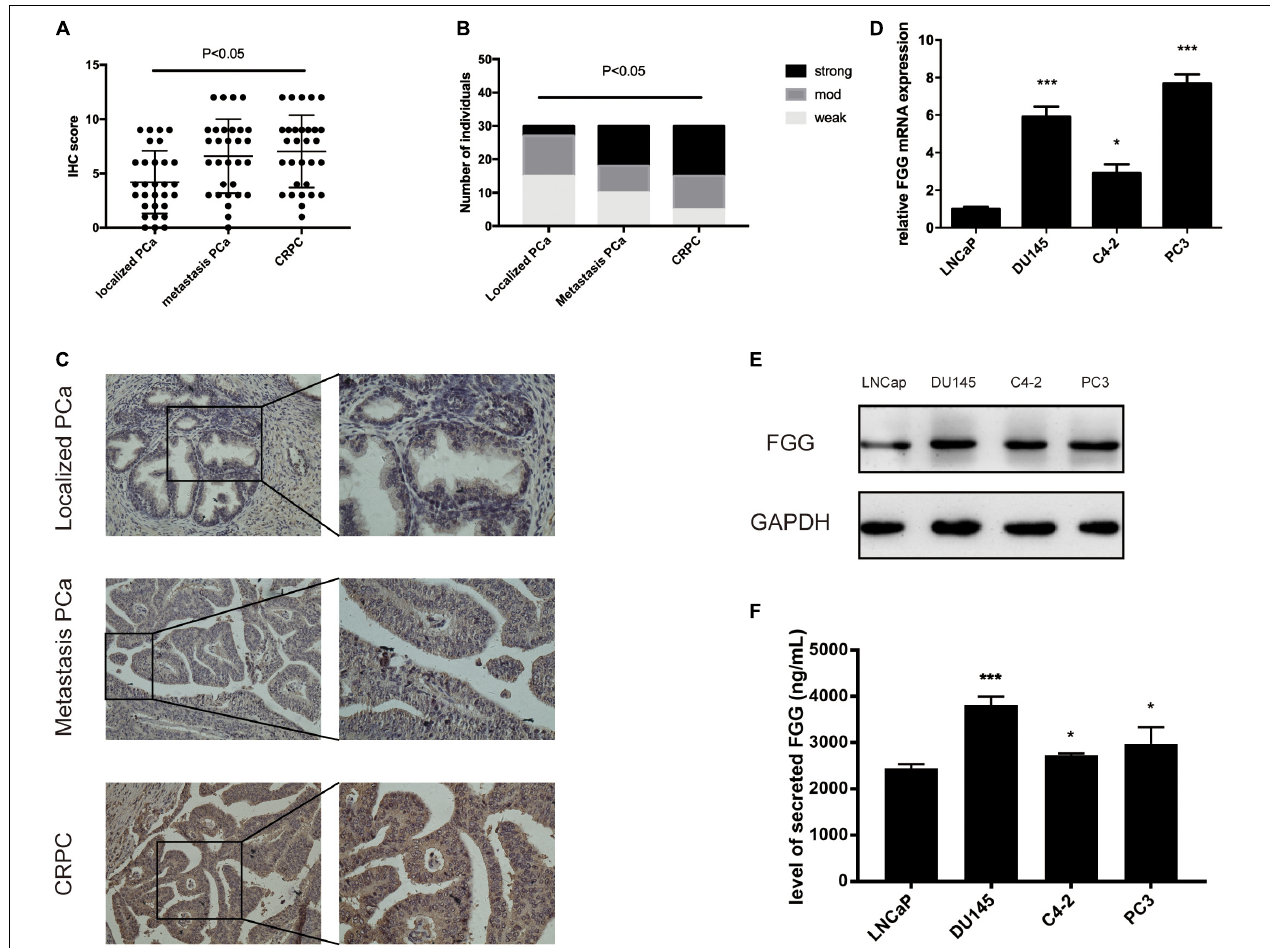
FIGURE 2 | Upregulation of FGG expression in CRPC tissues and cells. (A) FGG IHC scores of localized PCa, metastasis PCa, and CRPC tissues. (B) FGG staining intensity in localized PCa, metastasis PCa, and CRPC tissues. (C) Representative IHC staining images of various tissues. (D) Relative FGG mRNA expression in PCa cell lines. (E) Relative FGG protein expression in PCa cell lines. (F) Level of secreted FGG in PCa cell lines. * p < 0.05, *** p <